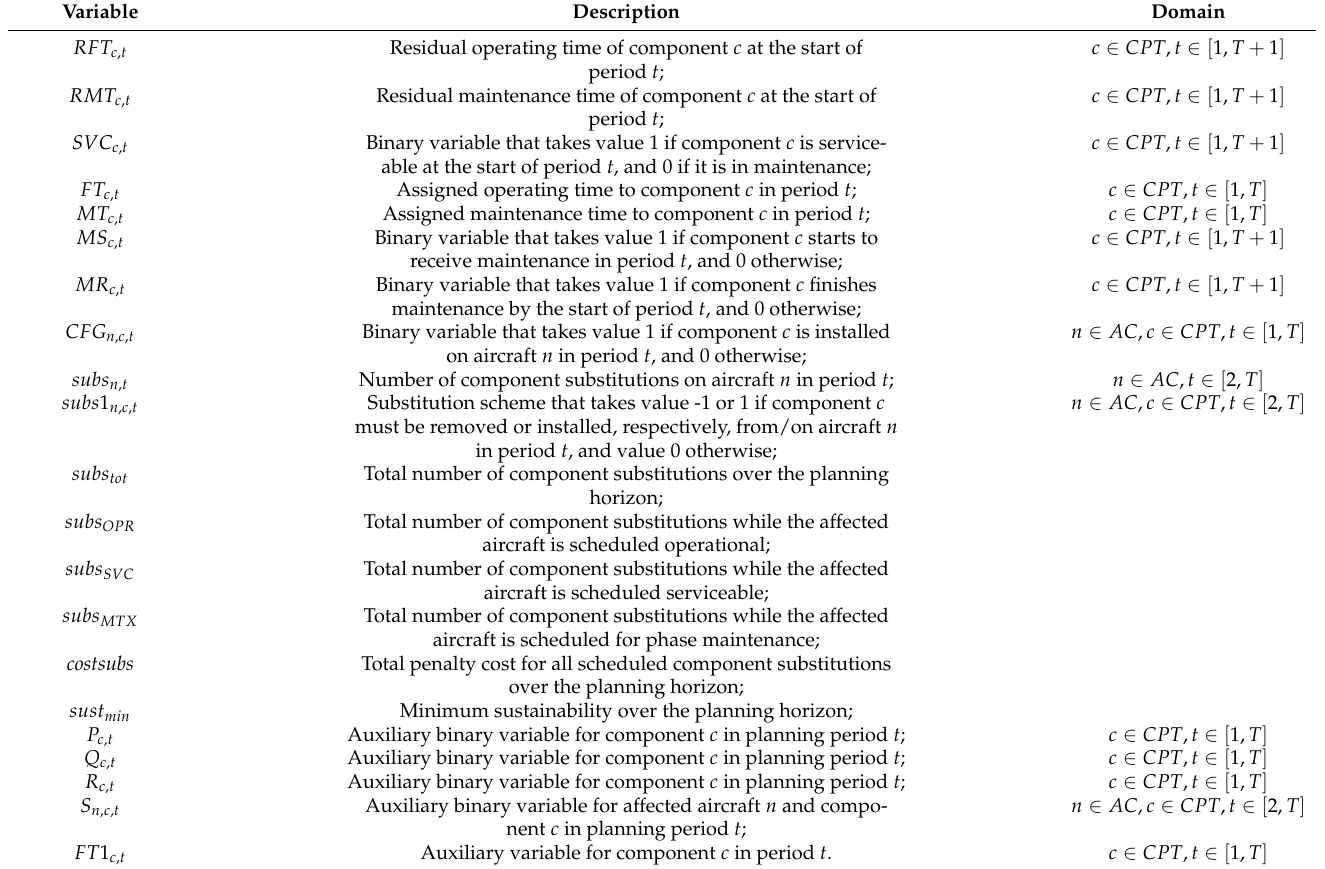
Table A2. CMP optimization model decision